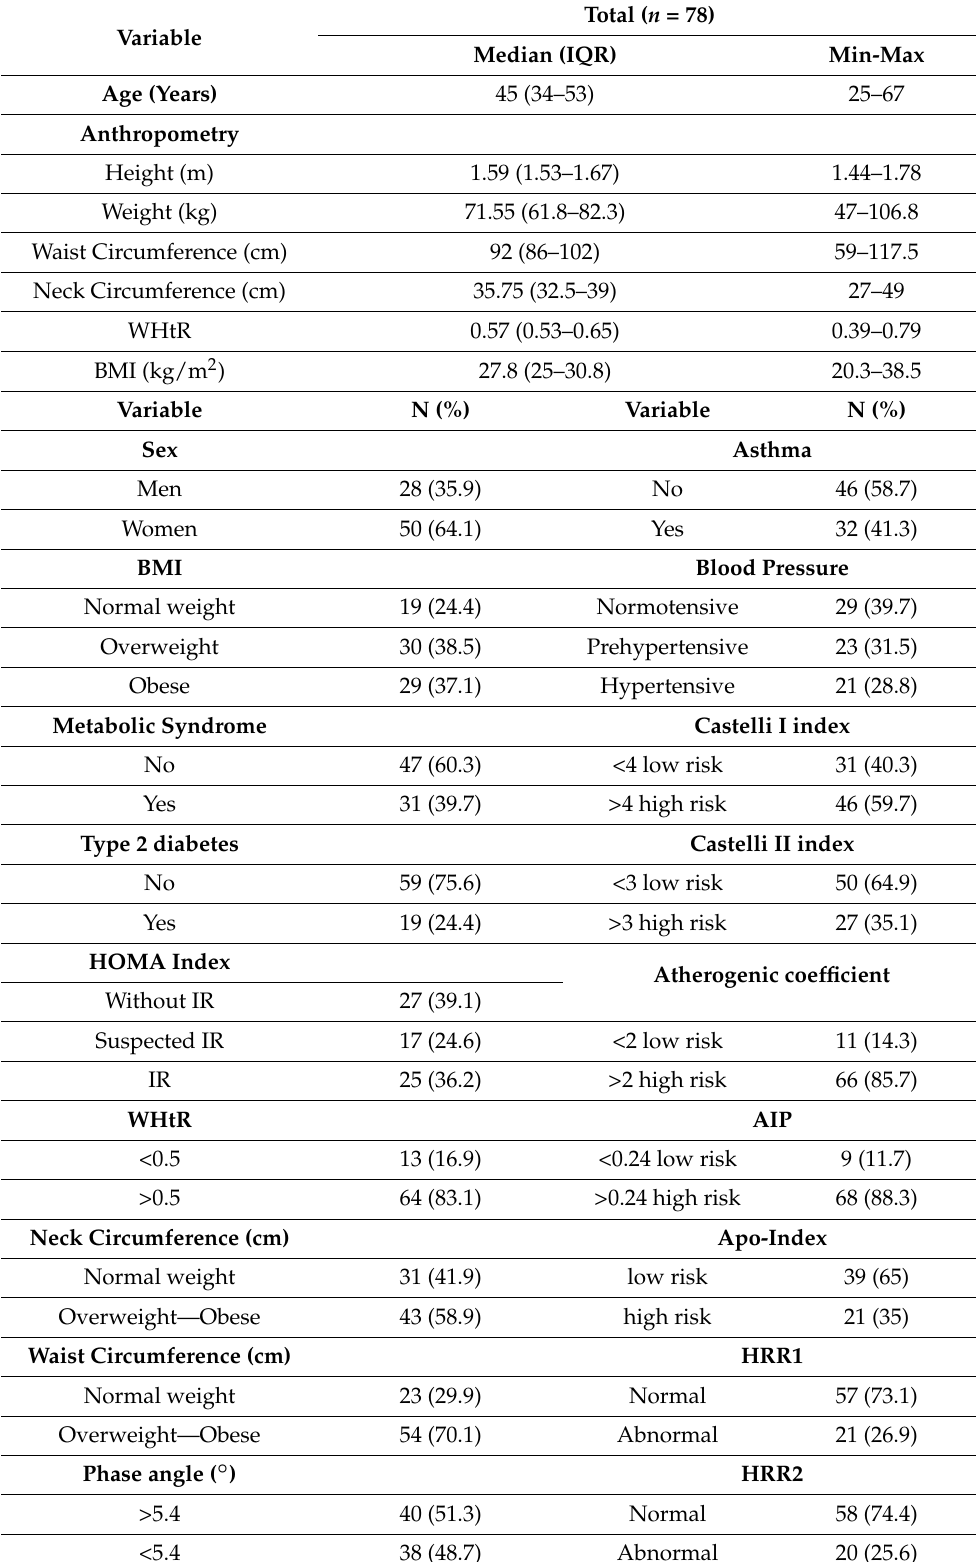
Table 1. General characteristics of the population recruited by National Institutes of Health, Mex- ico